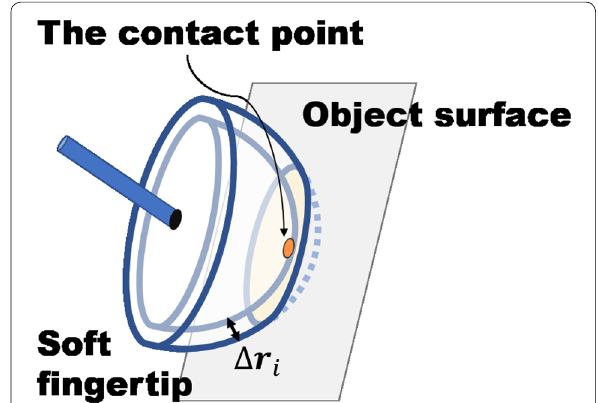
Fig. 14 Contact and deformation between the soft fingertip and the